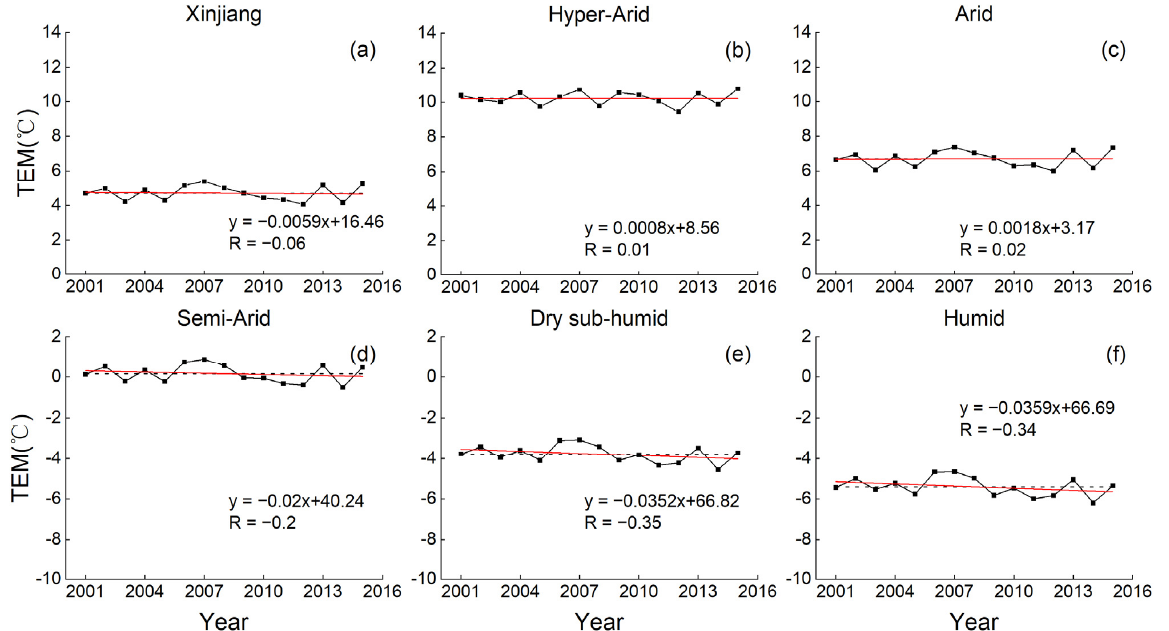
Figure 10. Inter-annual variations in TEM in different climate zones from 2001 to 2015 are shown for ( a ) the entire Xinjiang region, ( b ) hyper-arid region, ( c ) arid region, ( d ) semi-arid region, ( e ) dry sub-humid region, and ( f ) humid